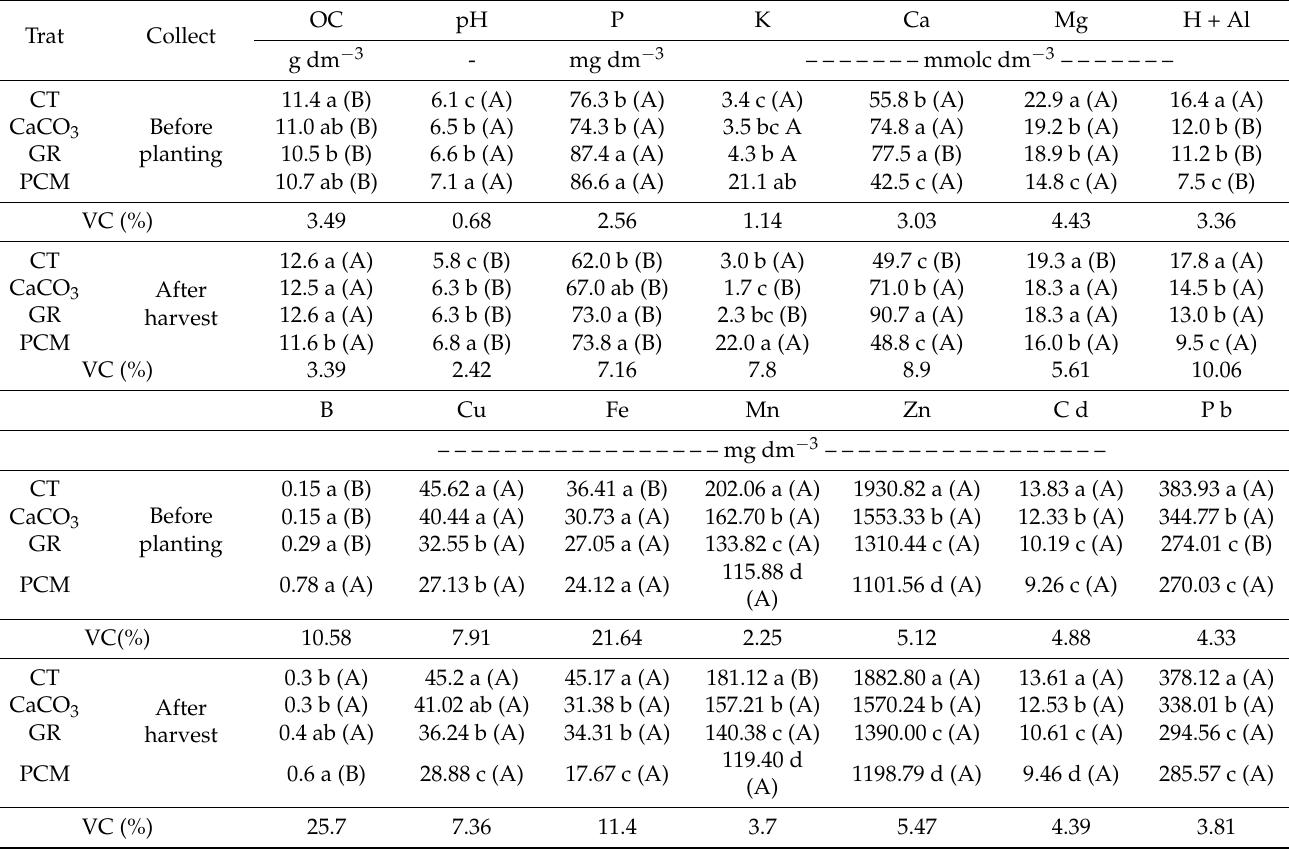
Table 3. Fertility attributes, nutrients and potentially toxic elements evaluated in soil samples before planting and after jack bean plant